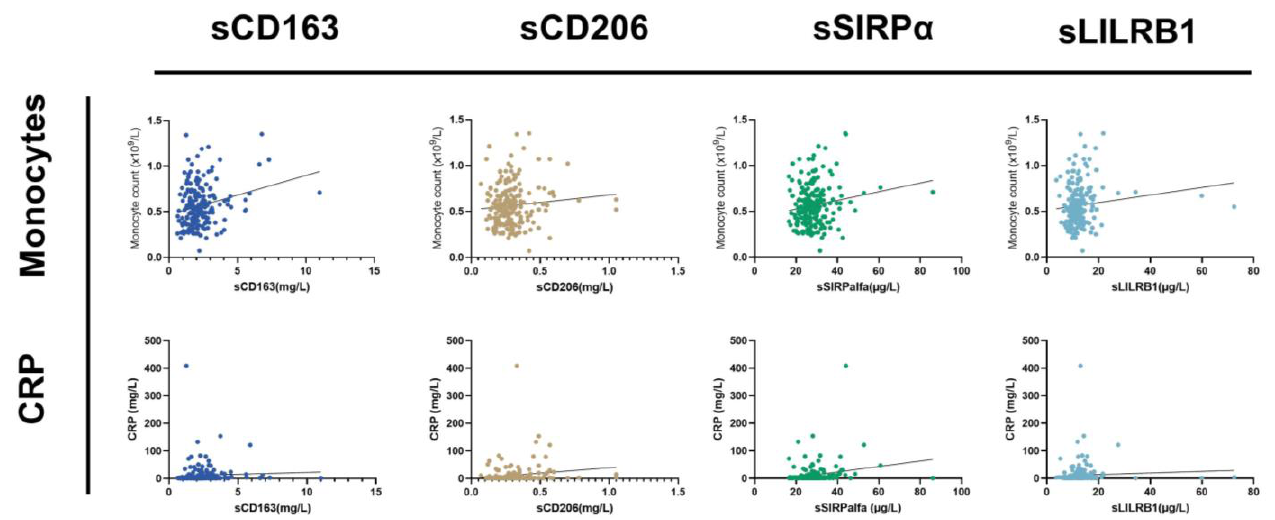
Figure 3. The correlations between the four macrophage biomarkers and monocyte count or CRP levels. The Kendall tau-b coefficient determined the strength of the association between the four different macrophage markers, monocyte level, and CRP levels in peripheral blood. Tau-b for mon- ocytes vs. sCD163 = 0.09; tau-b for monocyte vs. sCD206 = 0.007; tau- b for monocyte vs. sSIRPα = 0.09; tau-b for monocyte vs. sLILRB1 = 0.08. All indicated a weak association between the four dif- ferent macrophage markers and monocyte level. Tau-b for CRP vs. sCD163 = 0.22; tau-b for CRP vs. sCD206 = 0.14; tau- b for CRP vs. sSIRPα = 0.21; tau -b for CRP vs. sLILRB1 = 0.21. All indicated a medium association between the four different macrophage markers and CRP level .